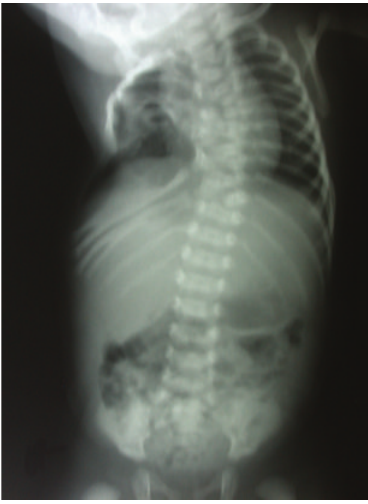
Figure 2: Abdominothoracic AP view showing multiple vertebral bodies defects involving the thoracic spine with related rib abnor- malities.